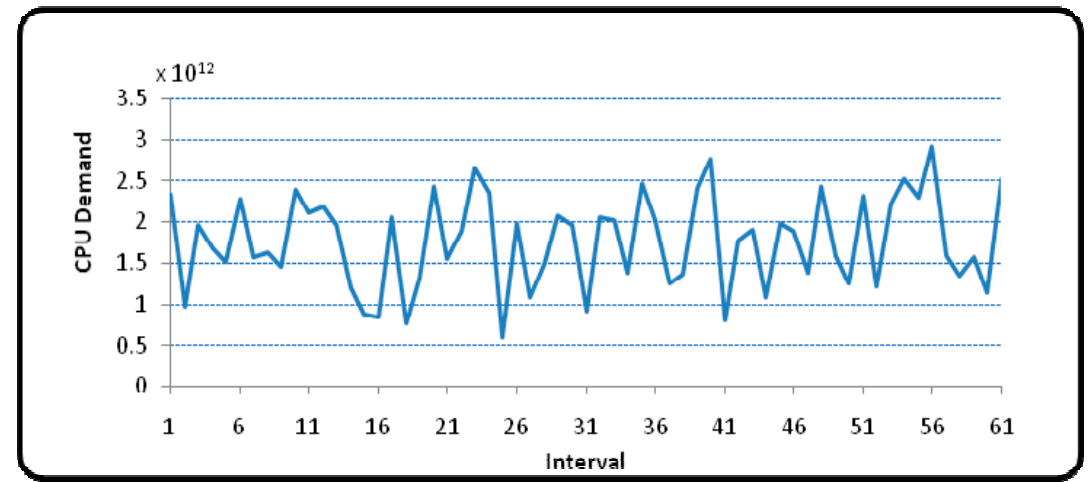
Figure 3. Processor demand without migration.